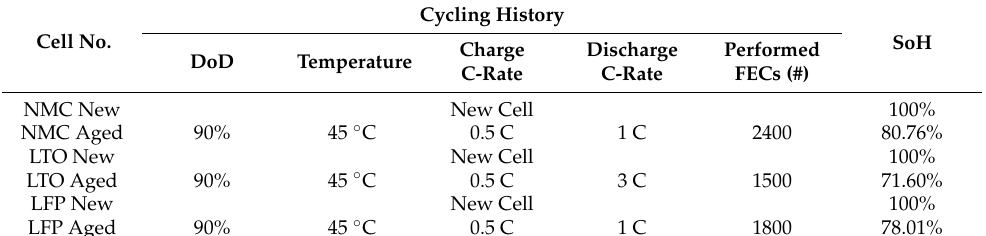
Table 2. Cell aging inventory.